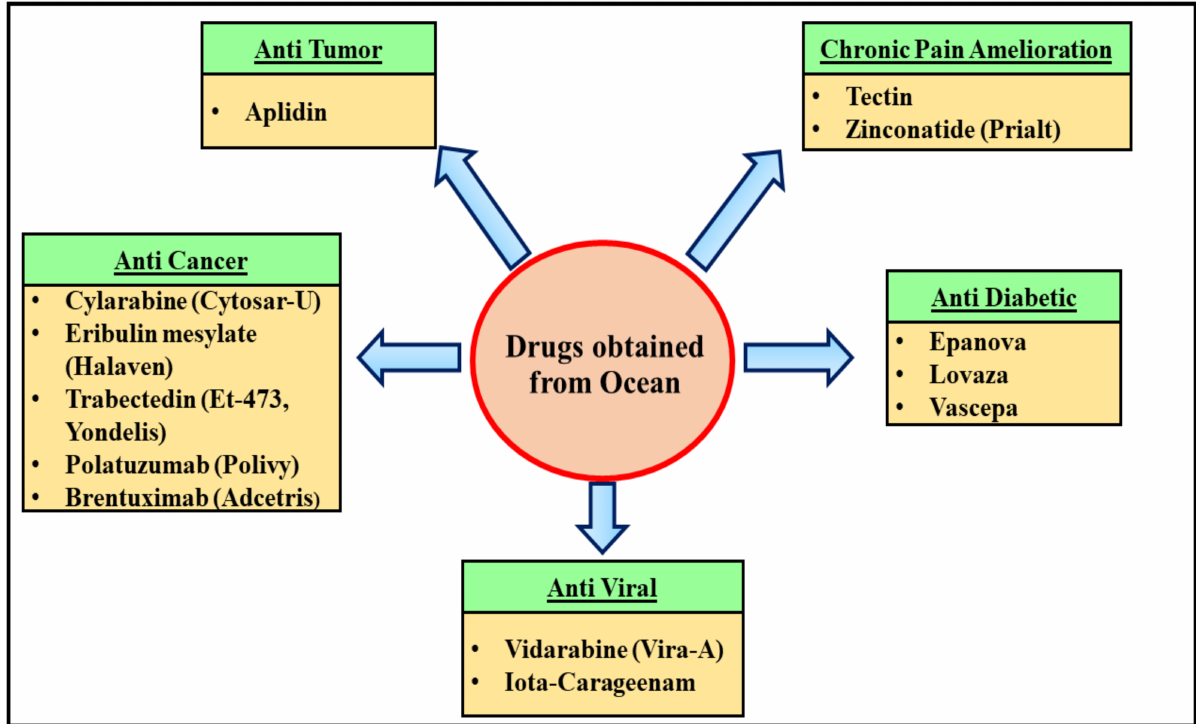
Figure 3. Marine drugs obtained from the ocean and their therapeutic uses in the management of conditions, starting from pain to life threatening diseases such as